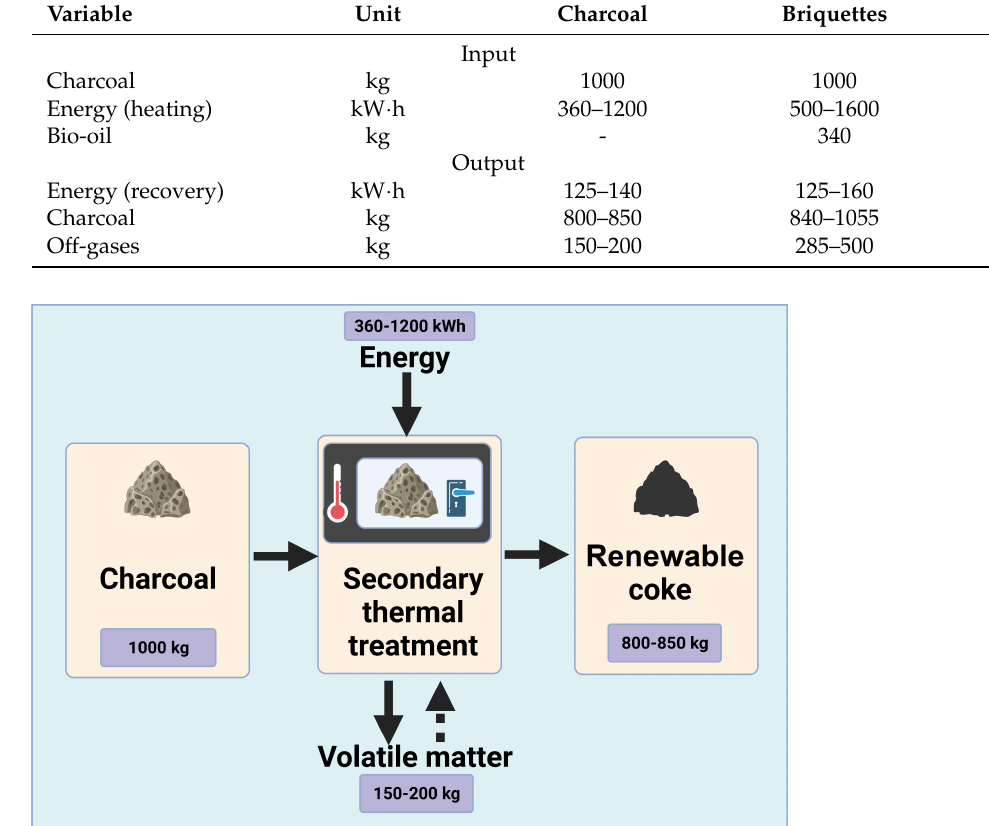
Table 5. Input parameter used for the secondary heat treatment of charcoal and briquettes.